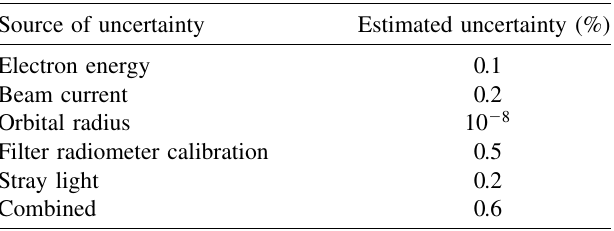
TABLE II. Components of the combined relative standard uncertainty for absolute flux